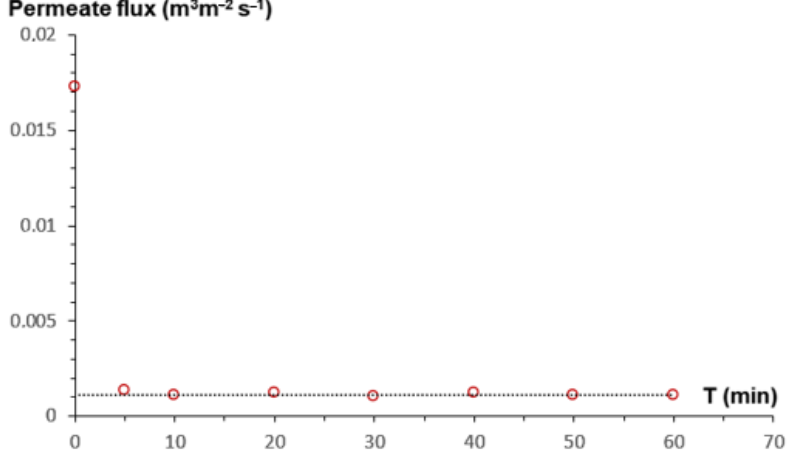
Figure 6. Changes in the purification efficiency, E (%), of three radioactive metal cations because of the membrane fouling.